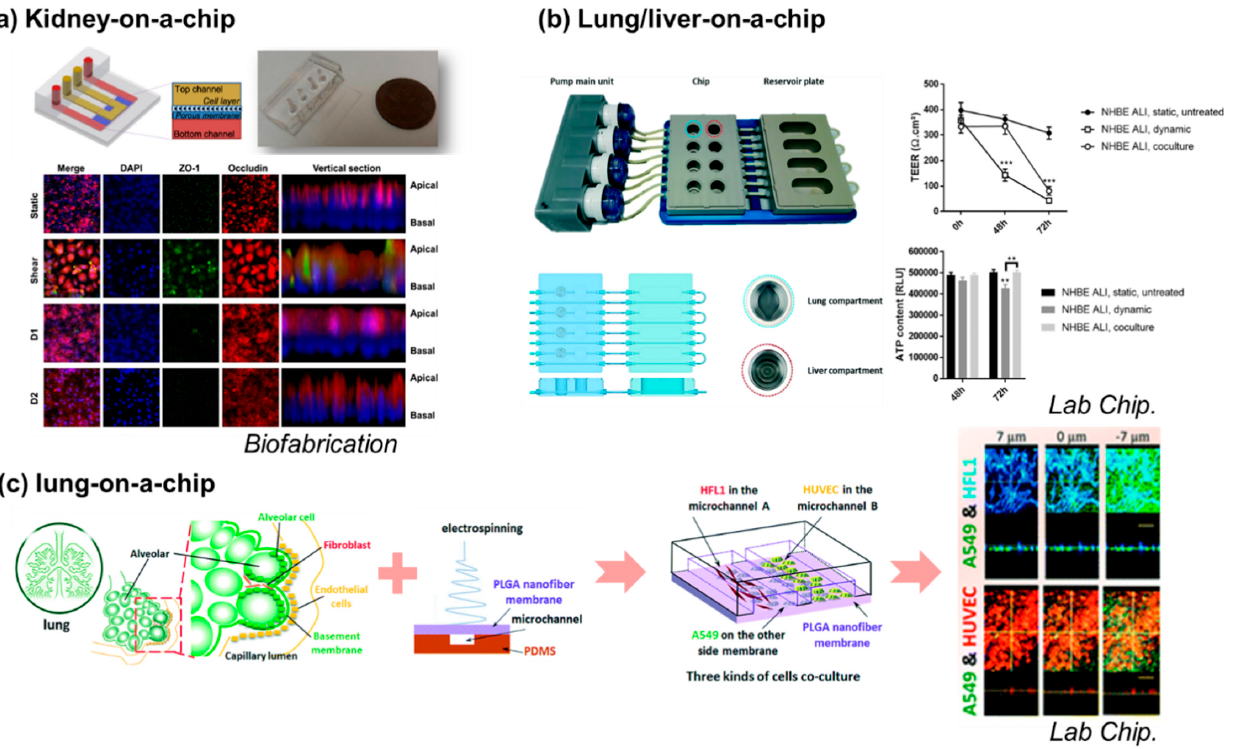
Figure 1. Organ-on-a-chip models for mimicking a single organ or a combination of organs. ( a ) Kidney-on-a-chip is developed for monitoring nephrotoxicity. Schematic design and actual image of a kidney-on-a-chip. Junctional protein expression of each group. The static and shear groups are measured before exposure to gentamicin, and D1 and D2 groups are measured 24 h after exposure to gentamicin. All groups show improved polarization compared to Transwell cultures. Source: Biofabrication, 2016 [56]; ( b ) lung/liver-on-a-chip combines two types of organs for investigating aerosol toxicity. A photograph of the chip system comprising the pump main unit with four pump heads, the PEEK chip, and the reservoir plate. A schematic view of the chip comprising four circuits is shown; each circuit includes two compartments to house the lung and liver tissues. The cross-section schemas of the plates show the path of the tubes and channels and the relative depth of each well. Source: Lab Chip, 2018 [55]; ( c ) a close-up view of the two compartments showing the groove pattern on the bottom of the wells; left ( c ). AFB1 toxicity was assessed using the lung/liver-on-a-chip. TEER and ATP content were measured in untreated or AFB1-exposed NHBE ALI tissues either in monoculture (NHBE ALI, dynamic) or coculture with HepaRG spheroids (NHBE ALI, coculture); right ( c ) nanofiber-membrane-assisted lung-on-a-chip system is used for anticancer drug testing. Source: Lab Chip, 2018